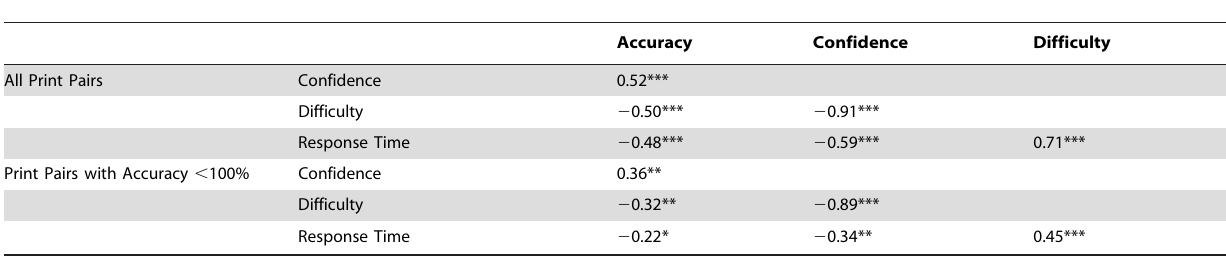
Table 1. Correlations between dependent